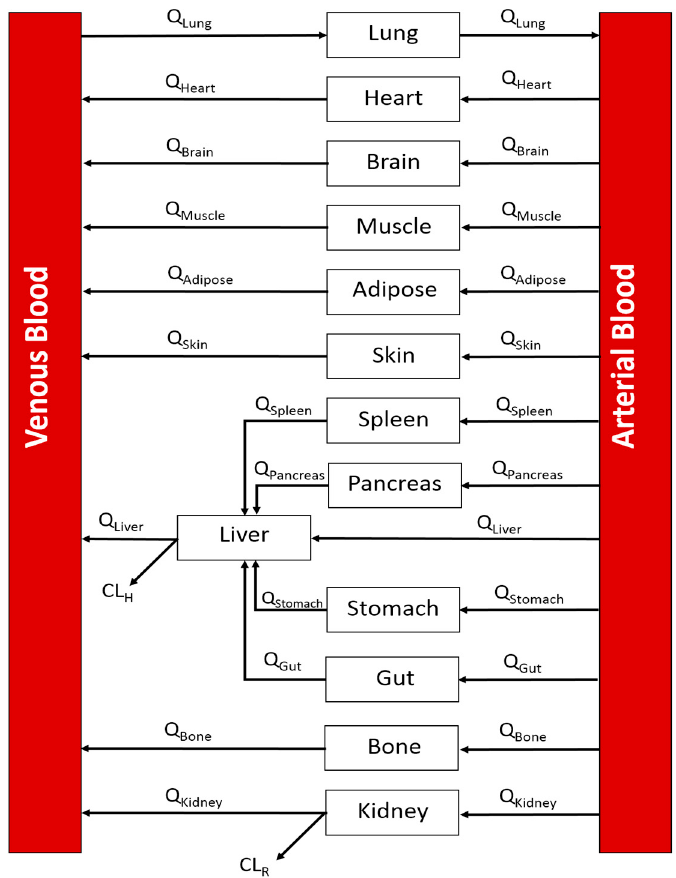
Figure 1. A generic whole-body PBPK model. Arrows indicated direction of blood flow. Q: blood flow; CL H : hepatic clearance; CL R : renal clearance.